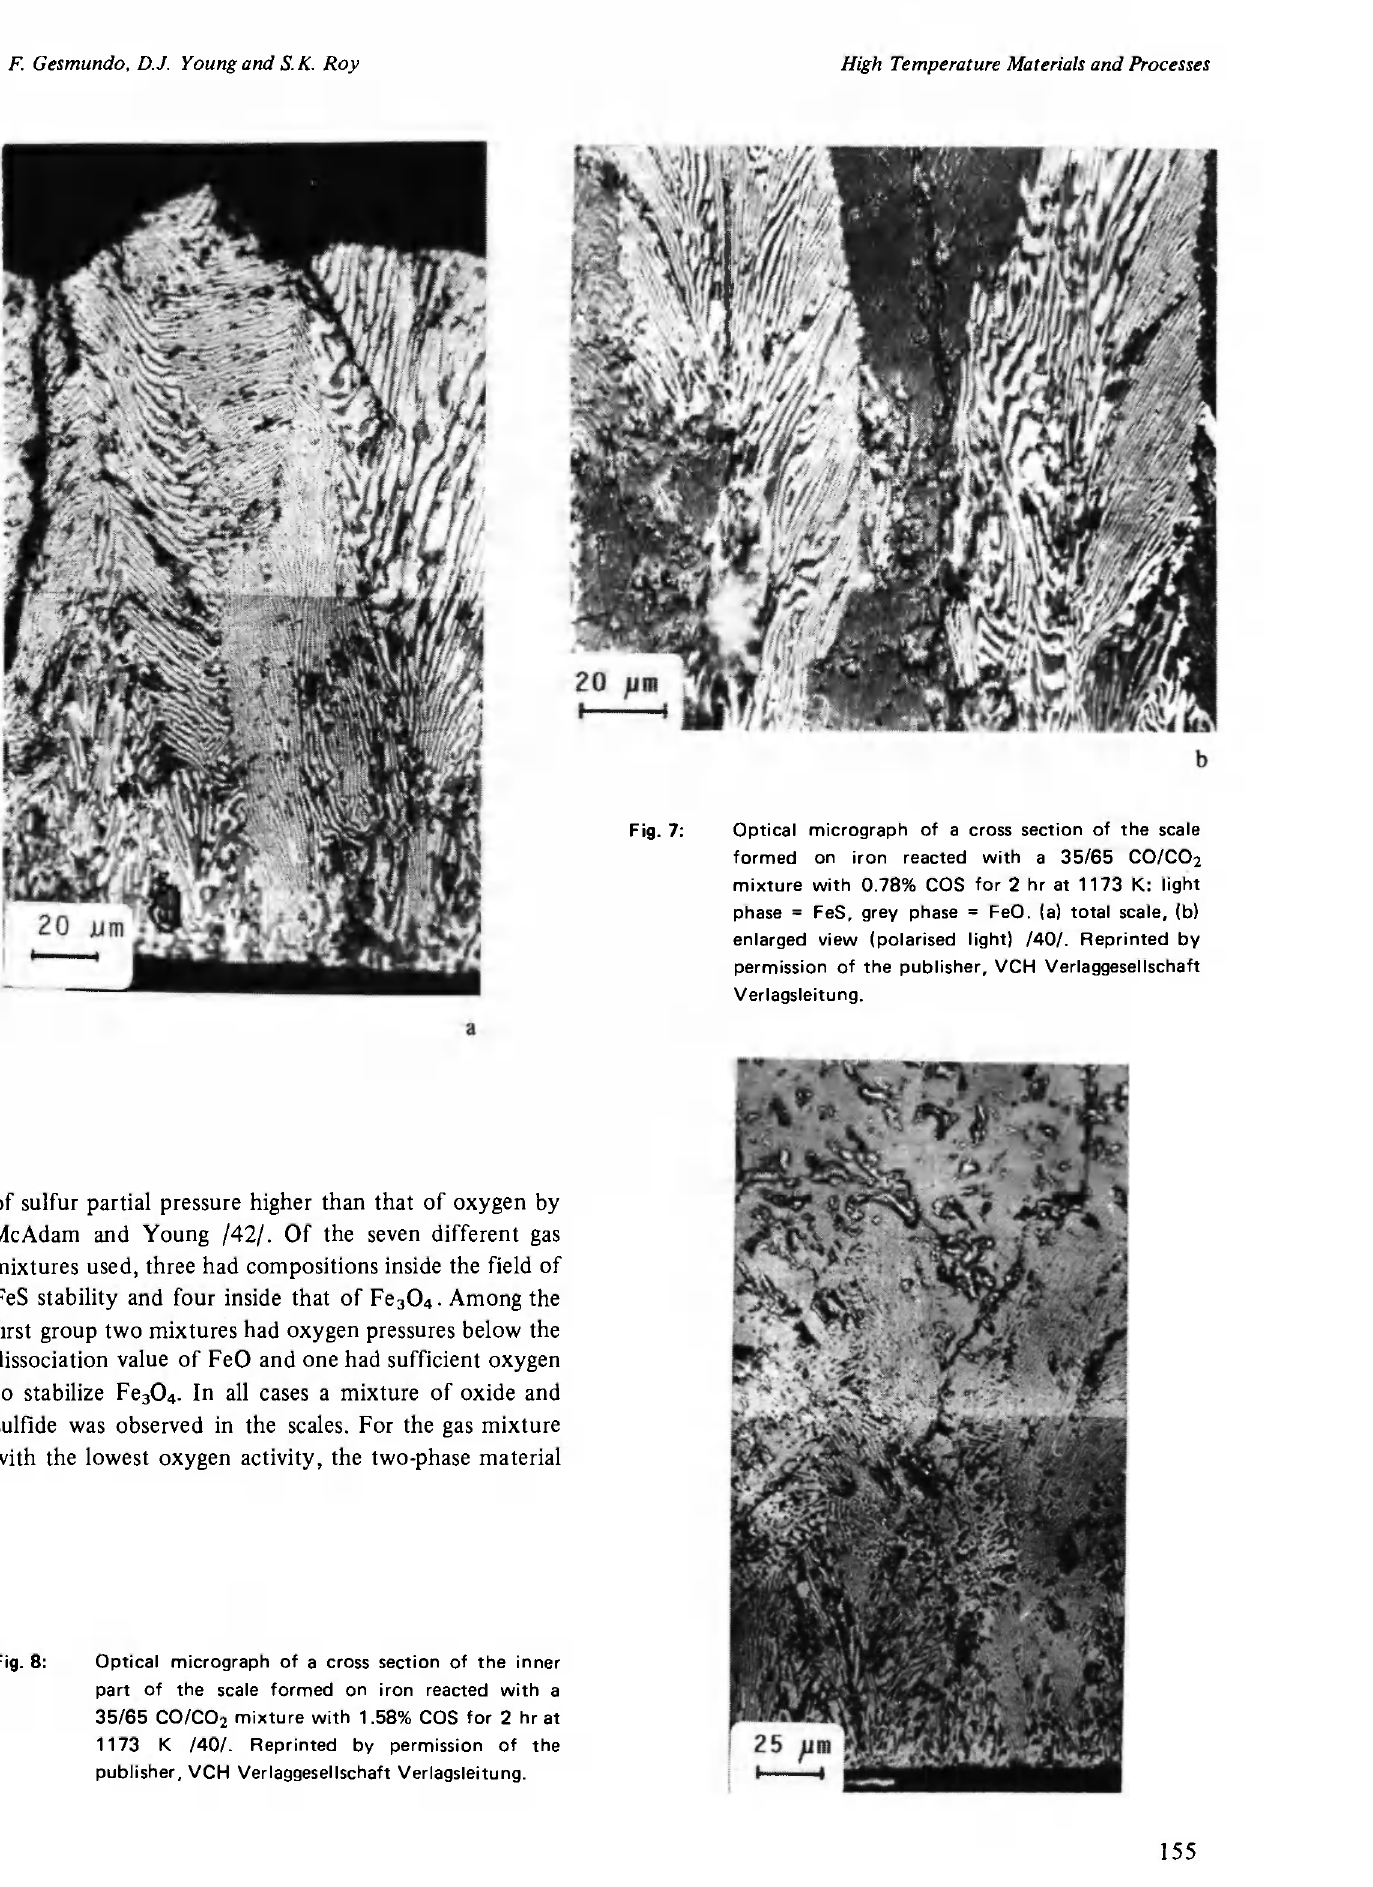
Fig. 8: Optical micrograph of a cross section of the inner part of the scale formed on iron reacted with a 35/65 C0/C0 2 mixture with 1.58% COS for 2 hr at 1173 Κ /40/. Reprinted by permission of the publisher, VCH Verlaggesellschaft